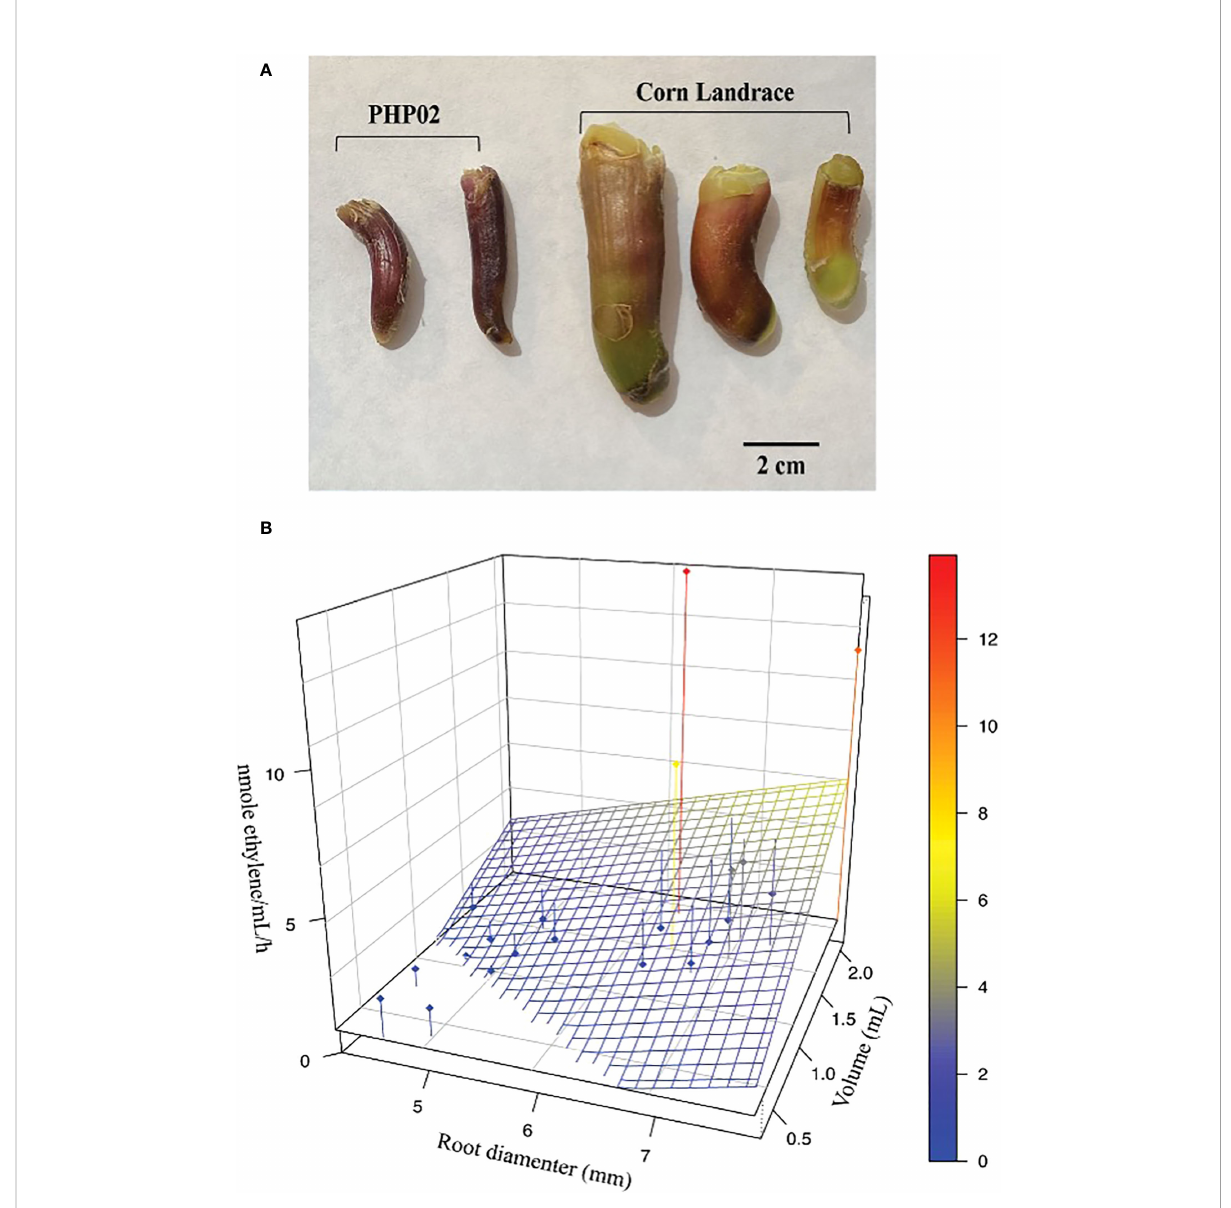
FIGURE 1 Aerial roots produced on different maize accessions secrete mucilage and support biological nitrogen fi xation. (A) Aerial roots formed on the stem of maize accessions Ames 19897 that produce 1,5 mL of mucilage are longer and thicker than those produced in common maize variety PHP02 (25 µL). (B) There is a correlation between root diameter, volume of mucilage produced, and the ability to support nitrogen fi xation. Aerial roots from 22 distinct maize accessions showed variable diameters. Those with larger diameters tended to secret more mucilage, showing higher nitrogenase activity (nmol of ethylene per hour per mL of mucilage). The Blue to red color scale indicates the